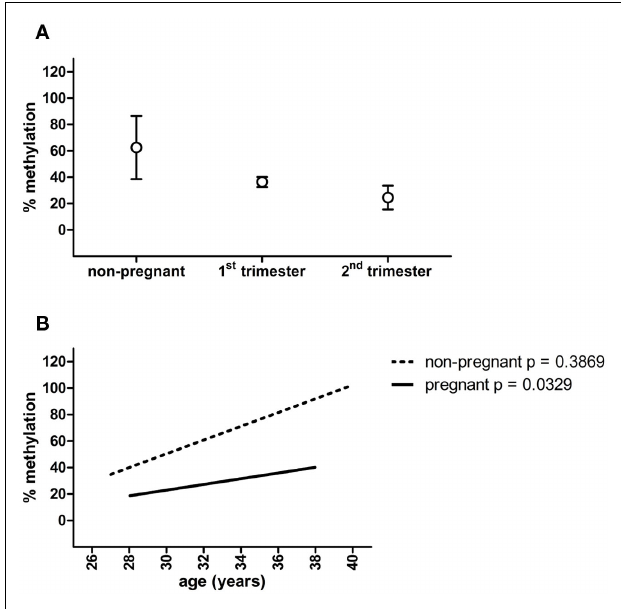
FIGURE 2 | MMP2 promoter methylation in non-pregnant, first trimester and second trimester plasma samples (A), and linear regression of MMP2 methylation percentages plotted against the age of the women (B). Circles represent mean ± SEM.